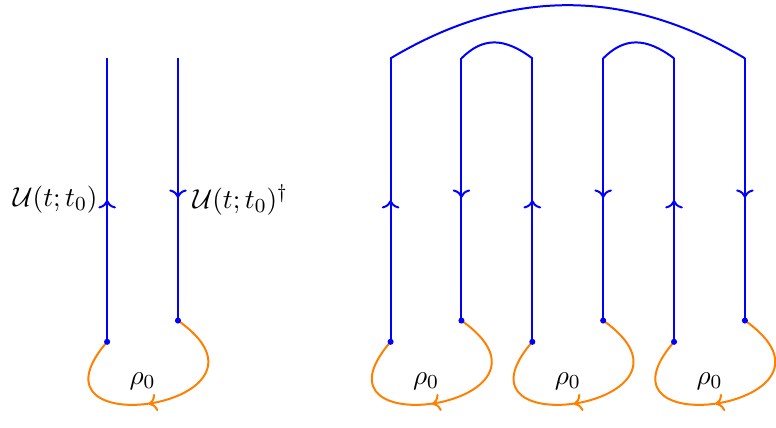
Figure 9. The thermal density matrix of a field theory can be prepared from a Euclidean path integral on a B = S 1 with t = β + it . Its time evolution ρ ( t ) in real-time is indicated on the × Σ t t E E left. On the right we depict the gluing of three copies of this real-time density matrix to compute the third moment Tr (cid:0) ρ ( t ) 3 (cid:1) . Since there are no sources in the Lorentzian evolution the forward backward evolution legs of this real-time contour cancel pairwise leaving behind a path integral that is localized on the Euclidean section, now on a thermal circle that it three times larger. This is a consequence of the standard collapse rules of real-time path integral